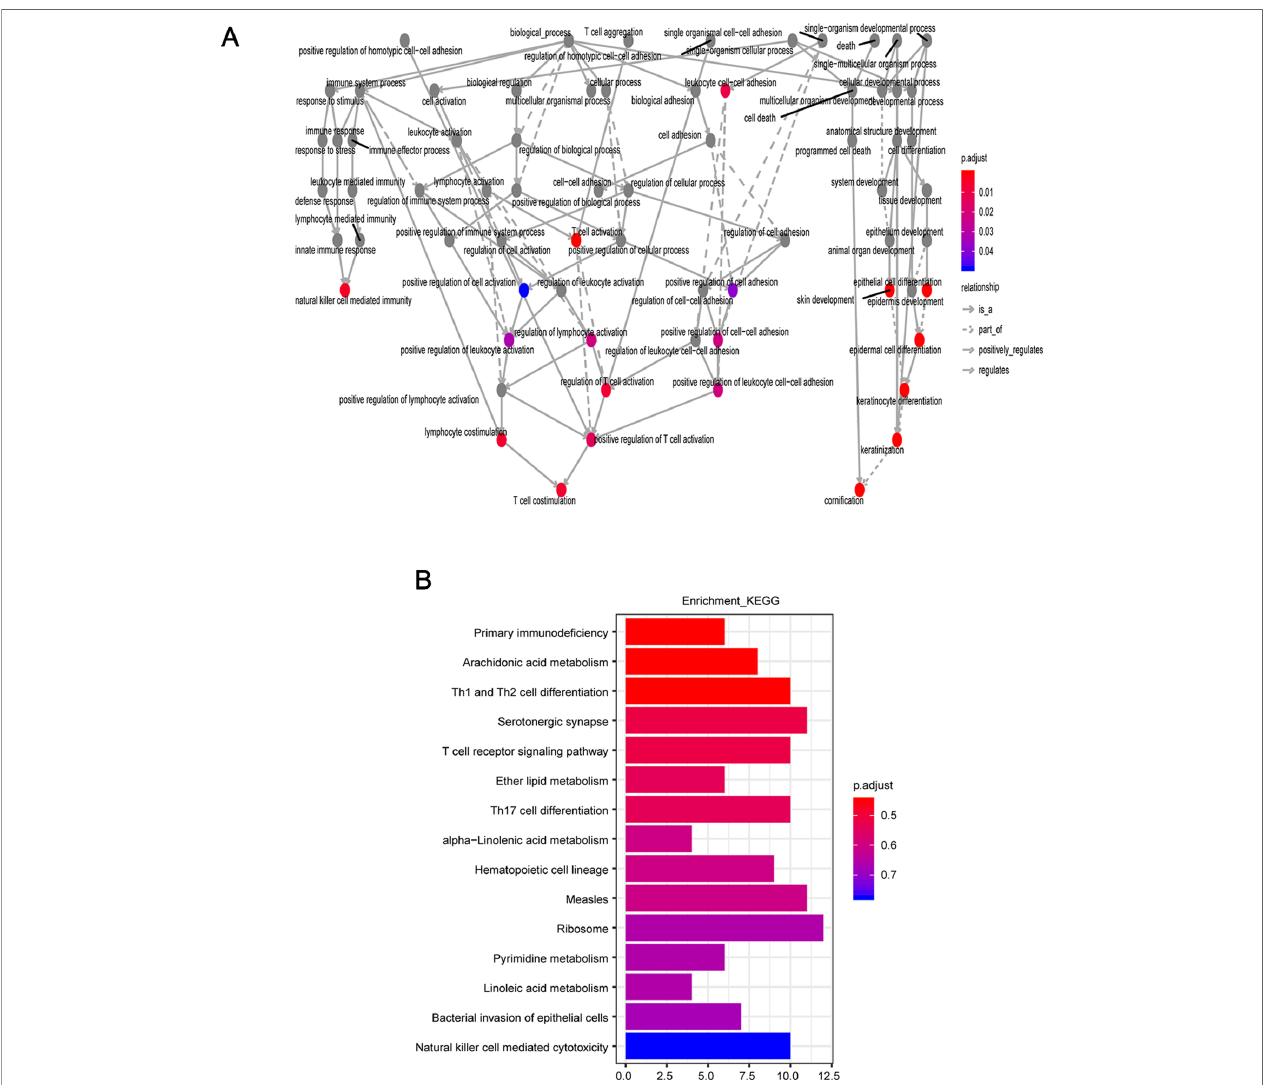
FIGURE 7 | Function enrichment analysis. (A) GO enrichment analysis. (B) KEGG enrichment